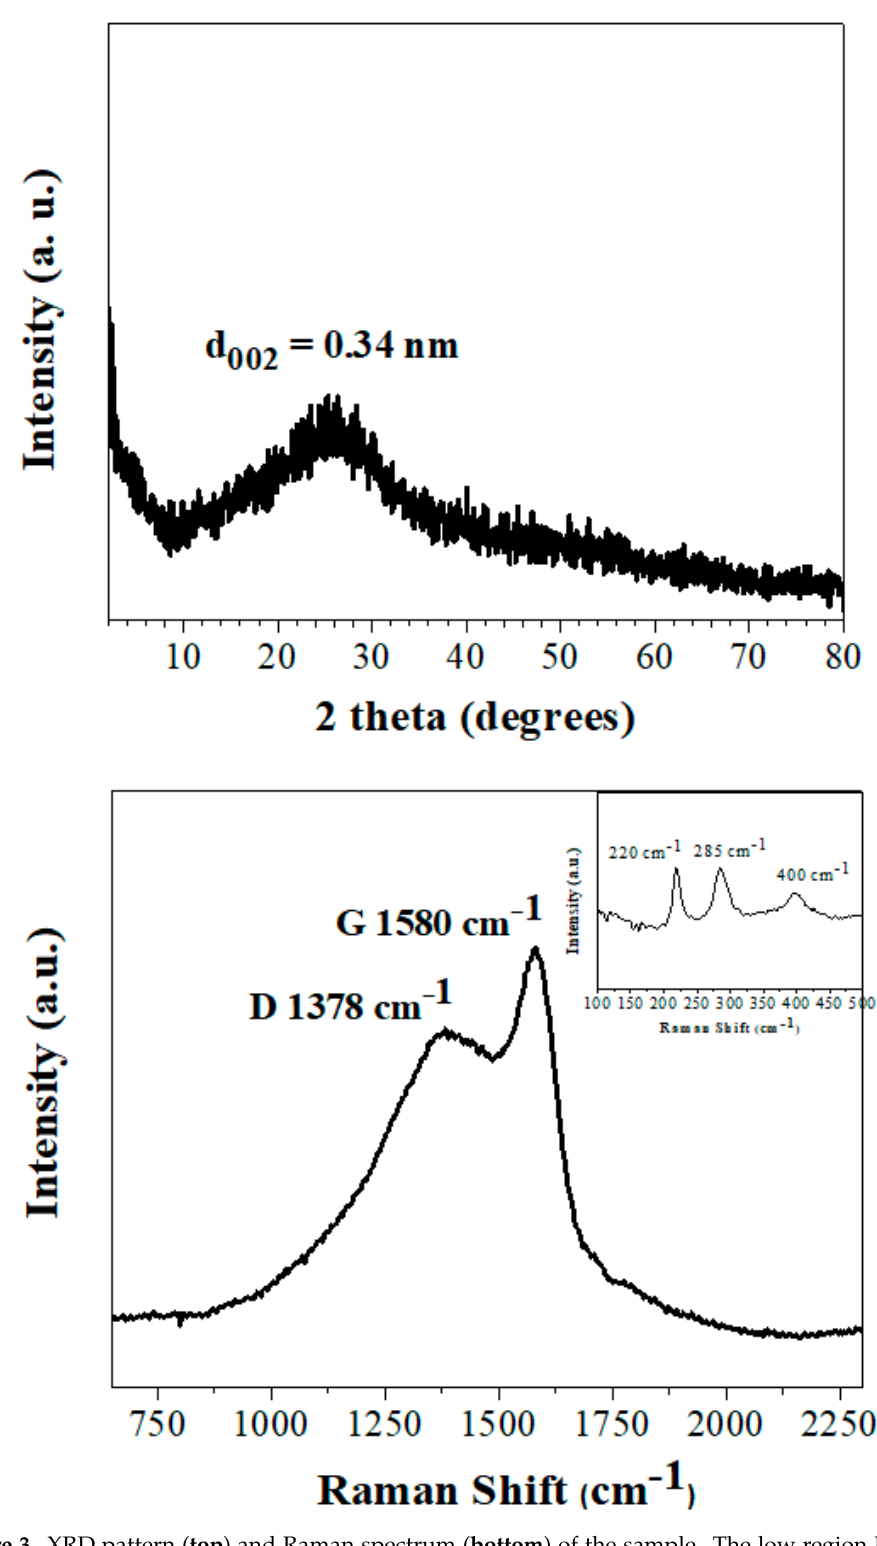
Figure 3. XRD pattern ( top ) and Raman spectrum ( bottom ) of the sample. The low region Raman spectrum showing the hematite peaks is given as inset.